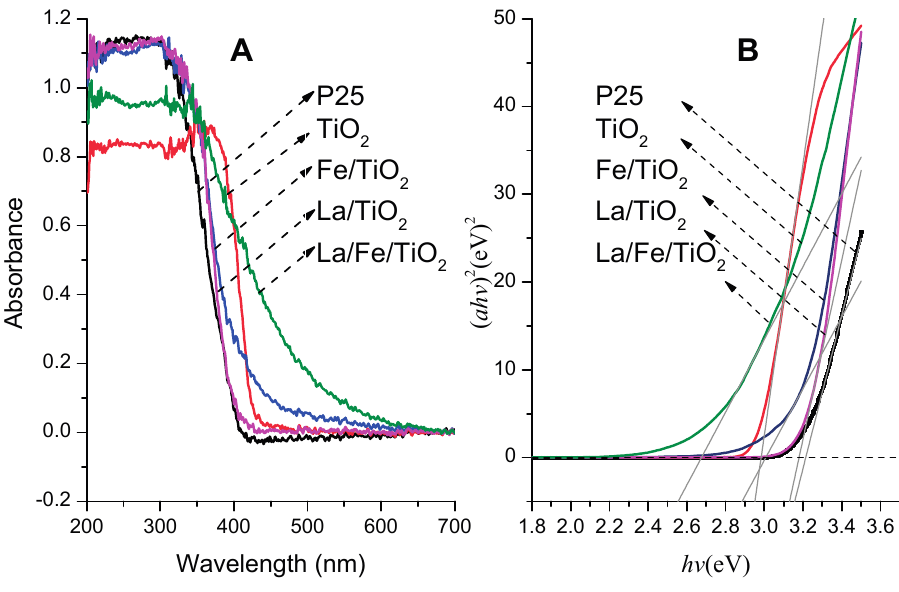
Figure 2. UV-Vis DRS of P25, TiO 2 , La/TiO 2 Fe/TiO 2 , and La/Fe/TiO 2 (( A ) Absorbance; ( B ) Plots of ( α h υ ) 2 versus ( h υ ) for